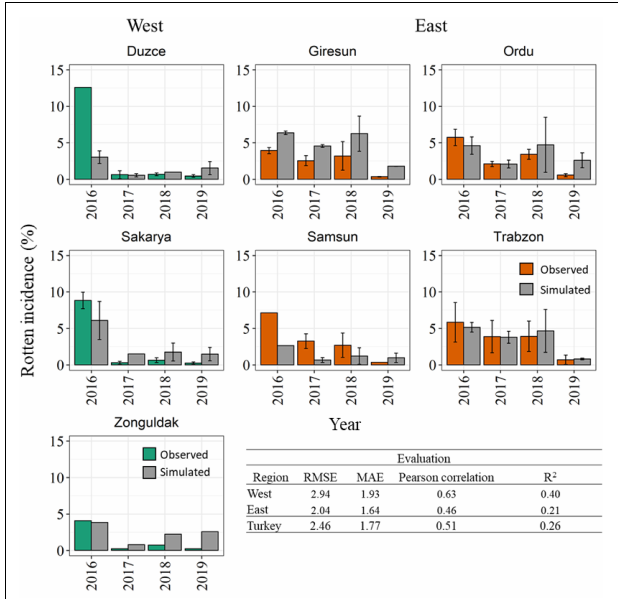
FIGURE 7 | Comparison between simulated (gray bars) and observed rotten incidence (%) in 2016–2019 in the seven main hazelnut growing municipalities in the Western (green bars) and Eastern (orange bars) Black Sea region. The variability associated with field surveys are presented by the standard error (SE) (error bars). Statistical metrics quantifying the model accuracy in the evaluation dataset are reported at country and regional level.